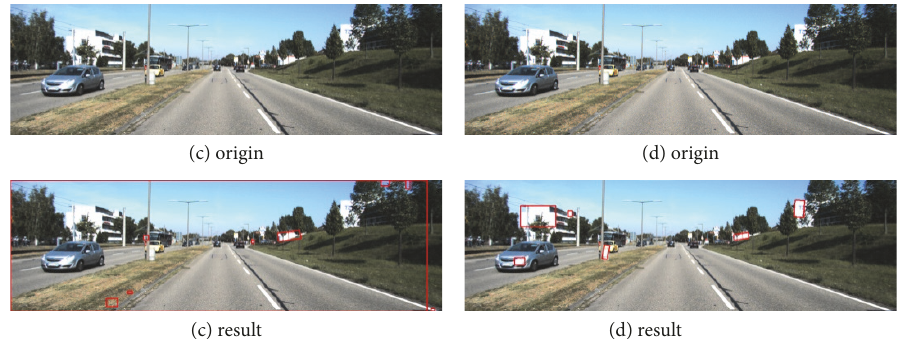
Figure 18: ROI selection of white of the sample frames (c) and